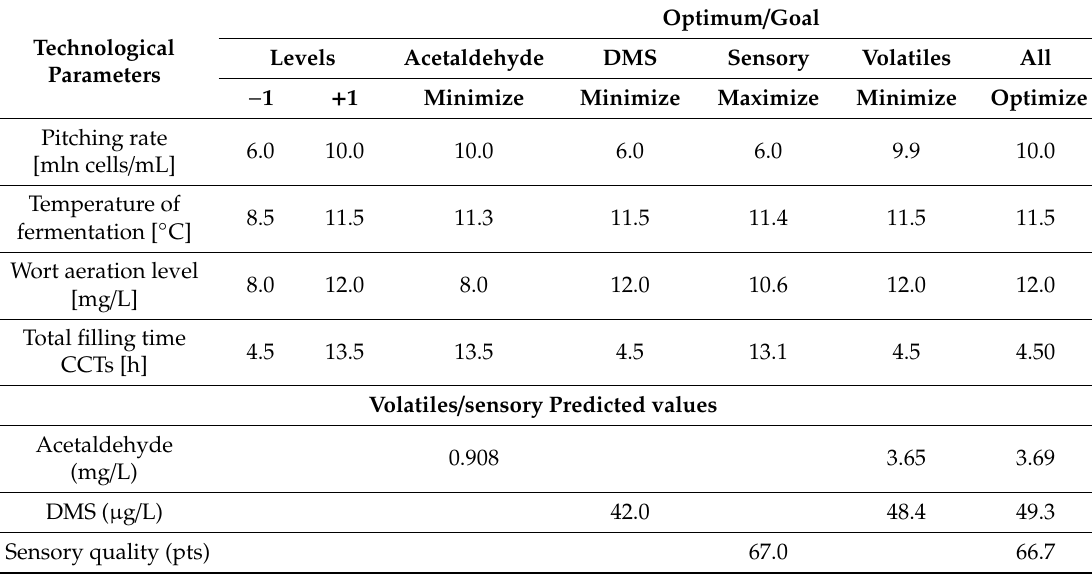
Table 5. Values of independent factors that optimized acetaldehyde, and DMS concentration in the tested beer, its sensory quality, the results from the multiple response optimization (volatiles = acetaldehyde + DMS) and all = volatiles + sensory quality and corresponding predicted values of